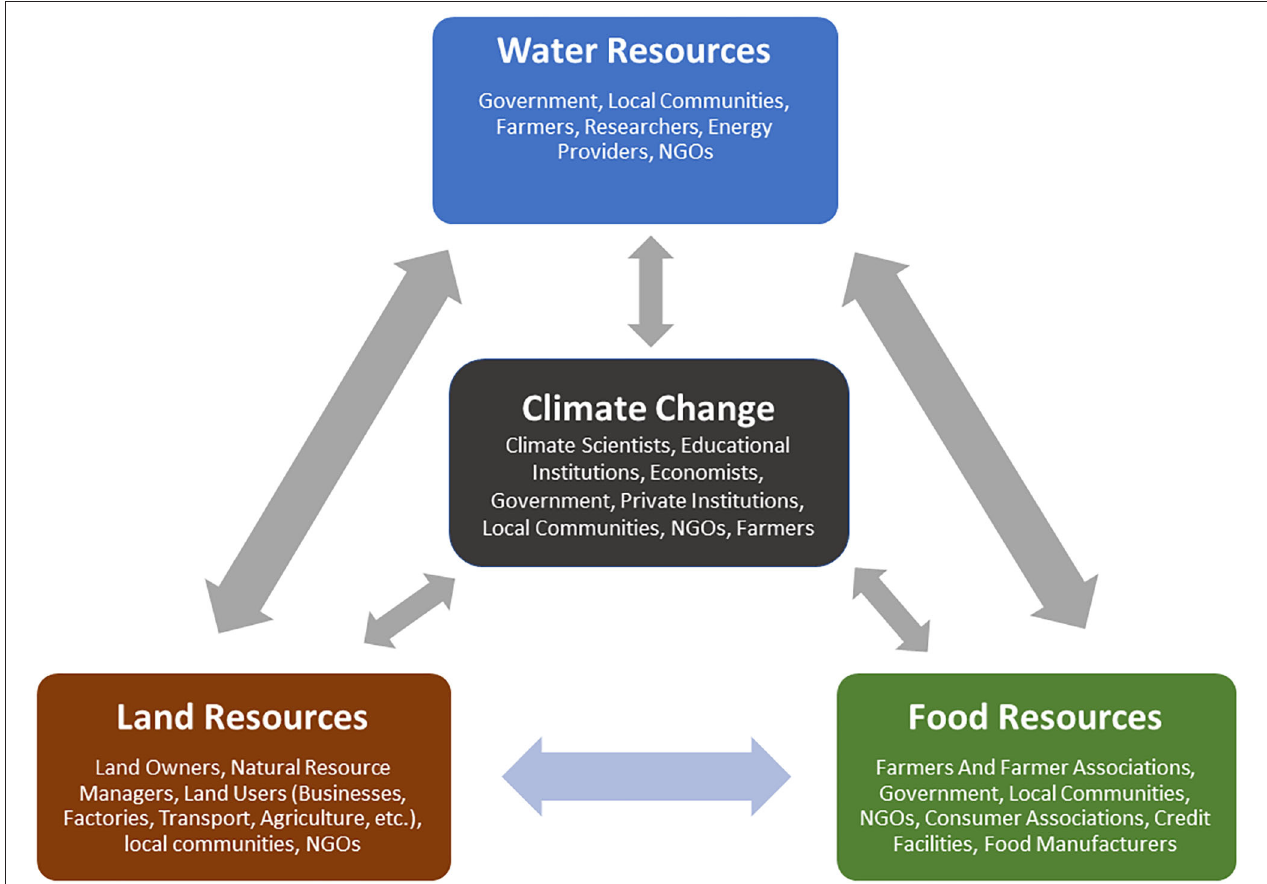
FIGURE 1 | A flowchart representing the climate change and WLF security nexus and the key stakeholders involved in the policymaking process.